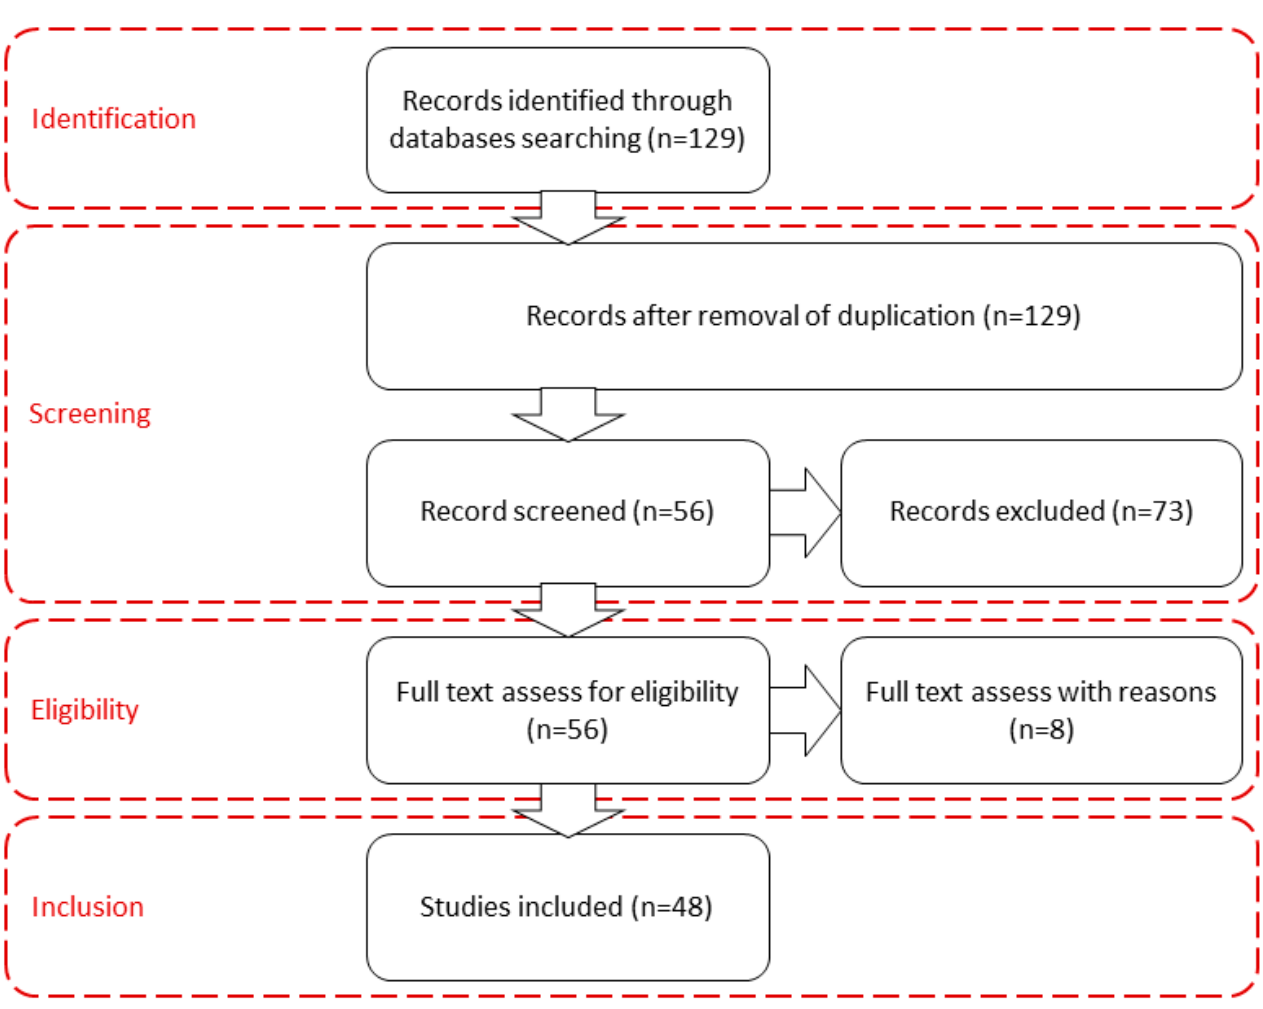
Figure 1. Systematic review on the instrument design of the space industry. Table 2. Summary of the studies information and their research focus on innovation, product design, instrument perfor- mance, and manufacturing.